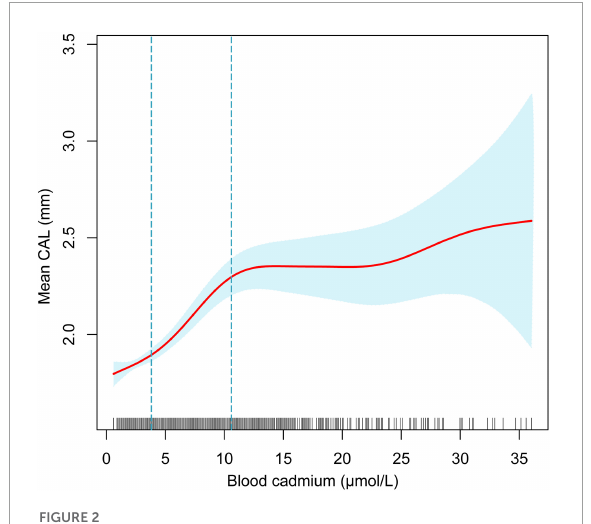
FIGURE2 The non-linear relationship between blood cadmium and mean CAL. The blue area represents the 95% confidence interval. The red line represents point estimates. Age, sex, race/ethnicity, BMI, income-poverty ratio, education, vitamin D, smoking status, diabetes, frequency per week using floss and mouthwash, periodontal treatment, hypertension, hyperlipidemia, BMD, congestive heart failure, coronary heart disease, angina pectoris, heart attack, stroke, physical activity, and calcium intake were adjusted.